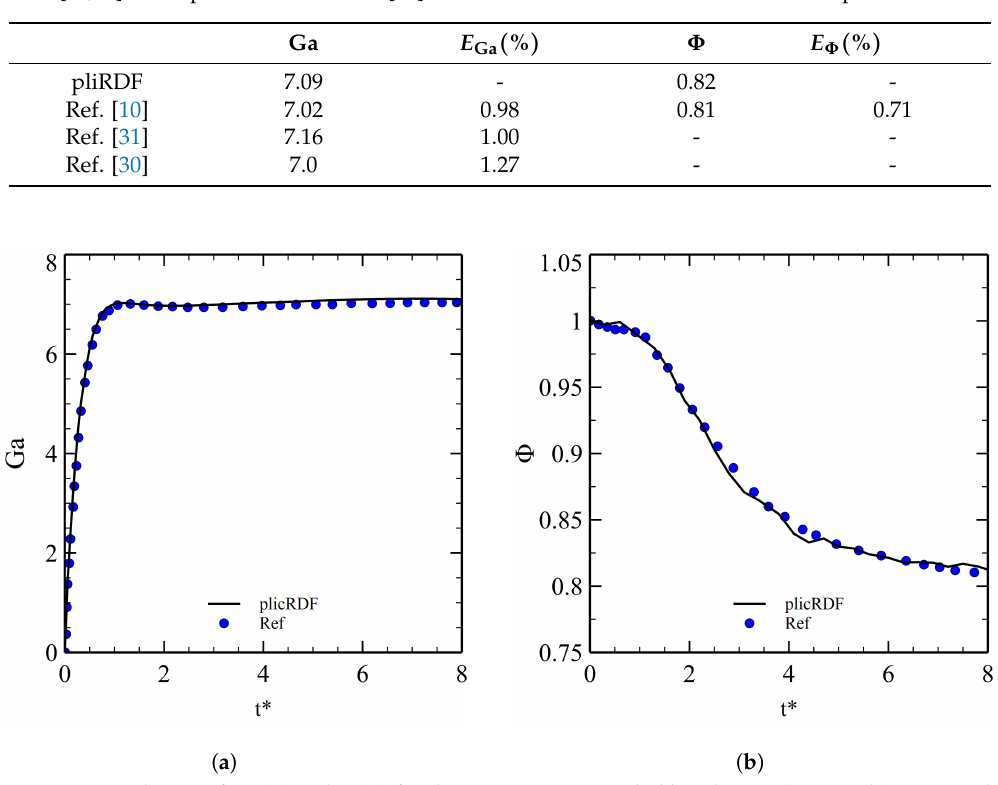
Figure 9. Evolution of Ga ( a ) and Φ ( b ) for the 3D C1 case provided by plicRDF (M4 mesh) compared with Ref.